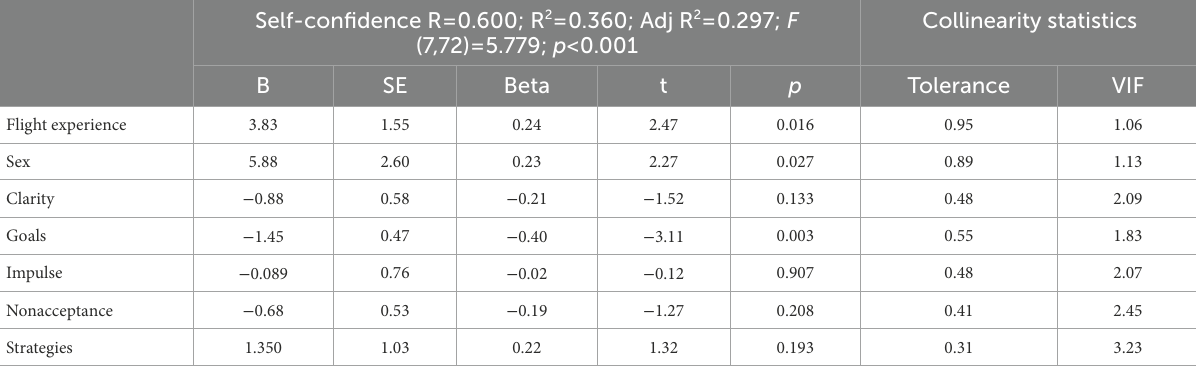
TABLE 3B Multiple regression model performed on self-confidence with flight experience, sex and clarity, goals, impulse, nonacceptance and strategies (emotional dysregulation’s subscales) as independent